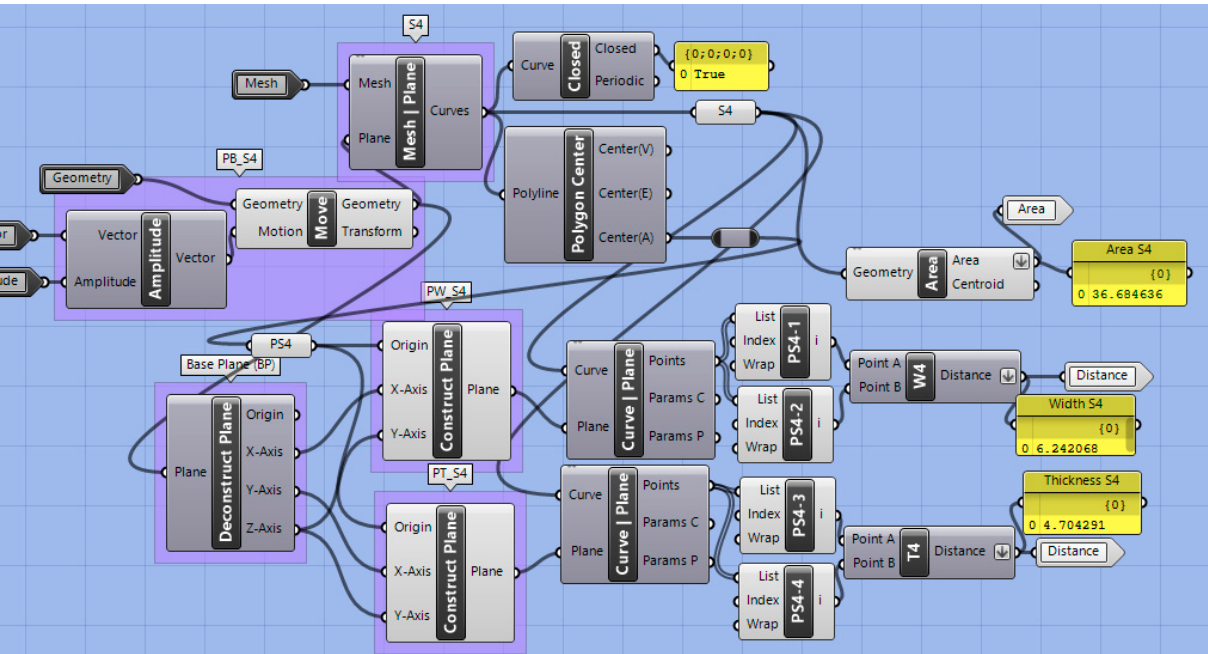
Figure 11. Lengths and angles of the extension. Sagittal (SL) and effective length (EL) information was given per section. SL1 had the same orientation as the main base plane (MPB). All sagittal length and effective lengths are parallel to each other. Moreover, angles ( α ) of the extension were calcu- lated.